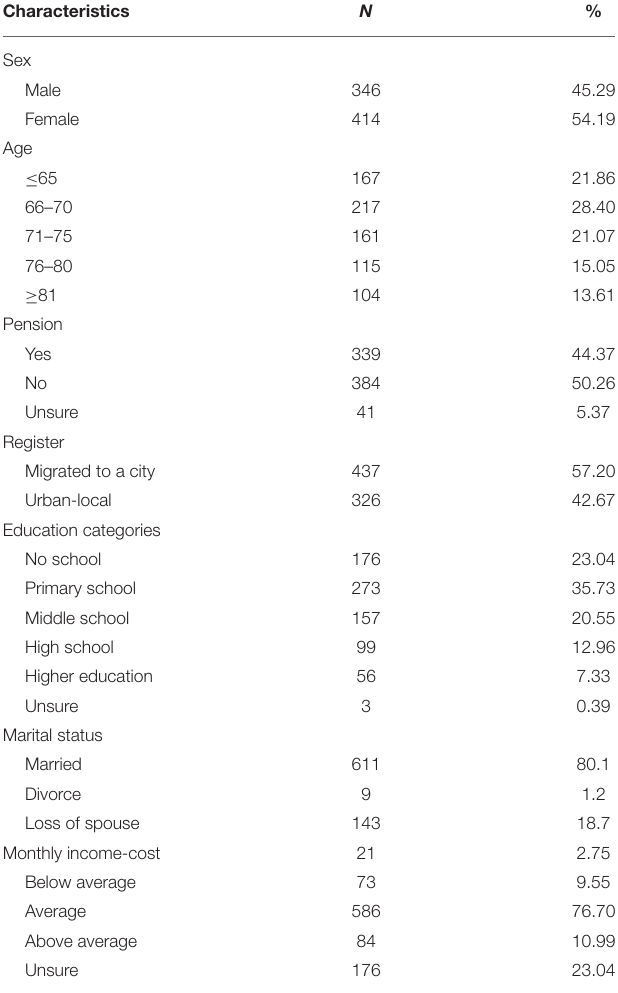
TABLE 1 | Demographic information of